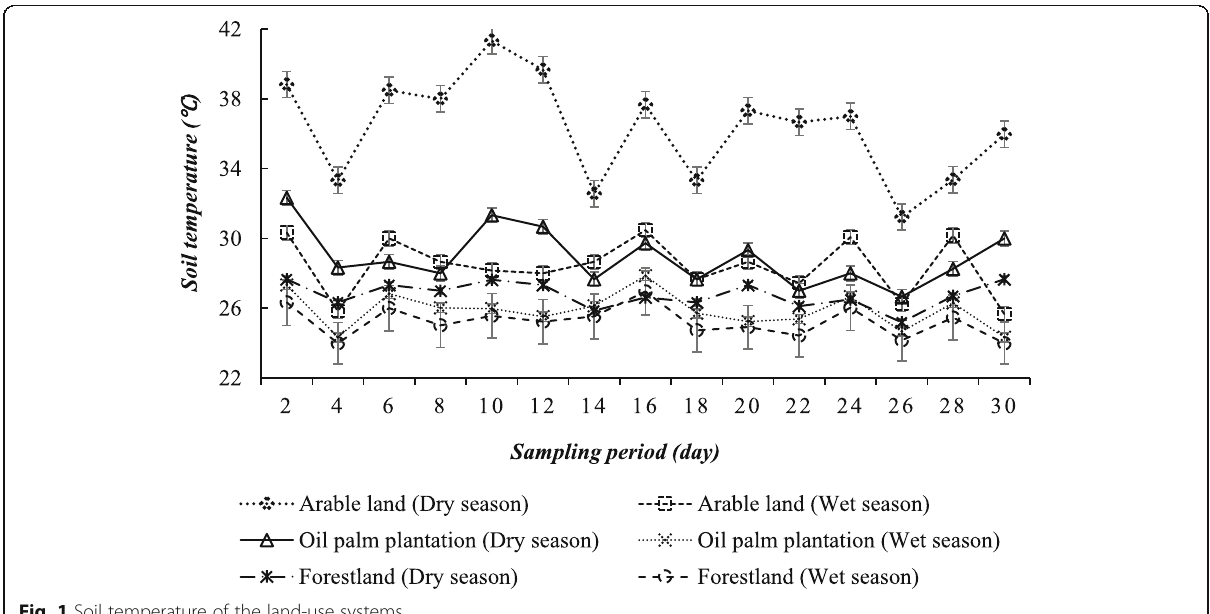
Fig. 1 Soil temperature of the land-use